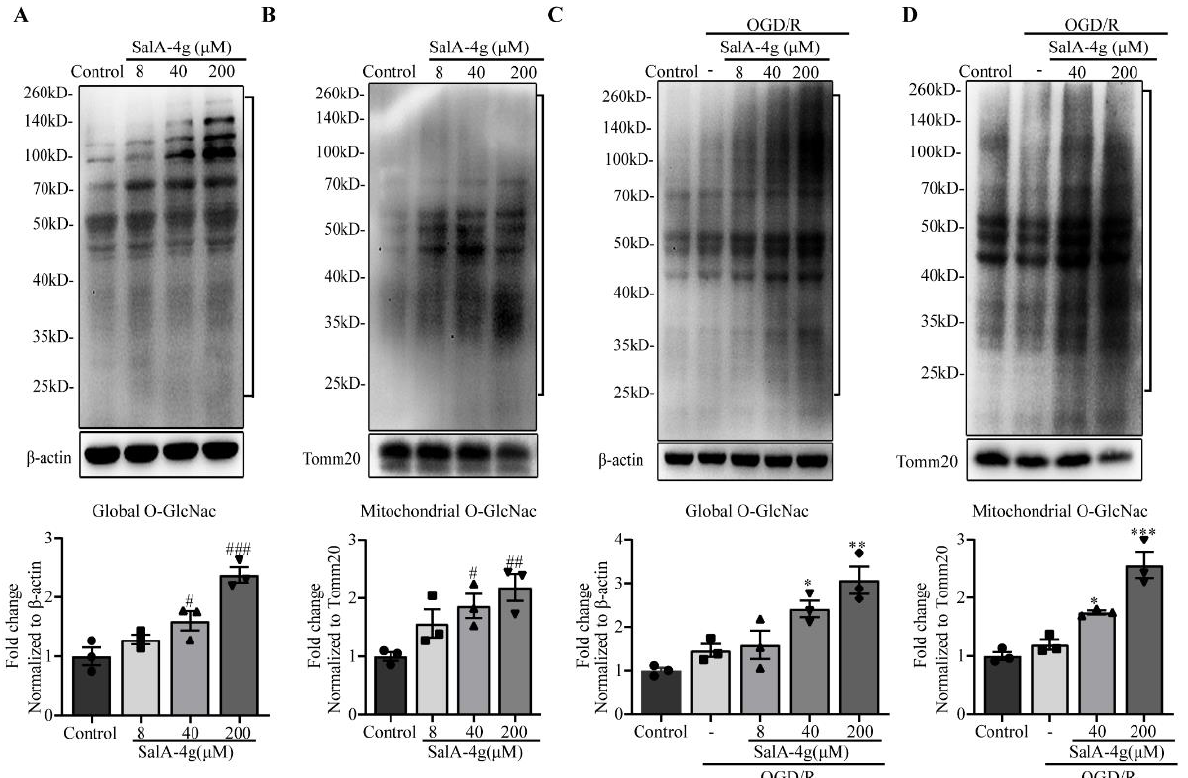
Figure 6. SalA-4g reinforces O-GlcNAc modification on global and mitochondrial proteins in cortical neurons under normal and OGD/R conditions. Global O-GlcNac levels ( A ) and mitochondrial O-GlcNac levels ( B ) in primary cortical neurons exposed to different concentrations of SalA-4g for 24 h. Global O-GlcNac levels ( C ) and mitochondrial O-GlcNac levels ( D ) of control cells, cells exposed to 2.5 h of OGD and 24 h of reoxygenation alone, and cells treated with different concentrations of SalA-4g during OGD/R period. Regions between 25 kDa and 260 kDa marked by brackets were used to quantify levels of O-GlcNAcylation. All values are presented as mean ± SEM ( n = 3); # p < 0.05, ## p < 0.01, and ### p < 0.001 versus control; * p < 0.05, ** p < 0.01, and *** p < 0.001 versus OGD/R alone.